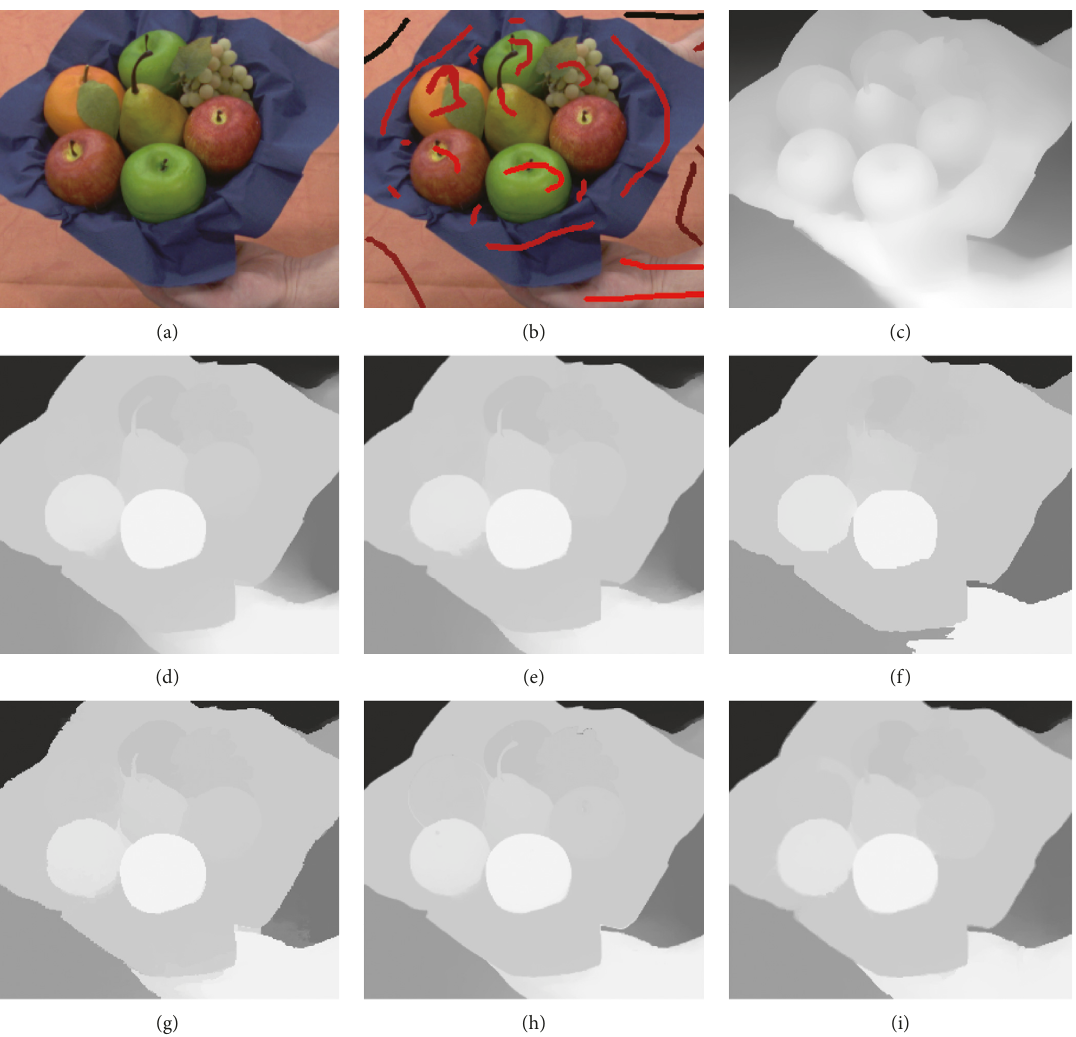
Figure 7: Results for RGBZ_07 in the absence of inaccurate scribbles. (a) Input image. (b) User scribbles. (c) Groundtruth. (d) Depth of